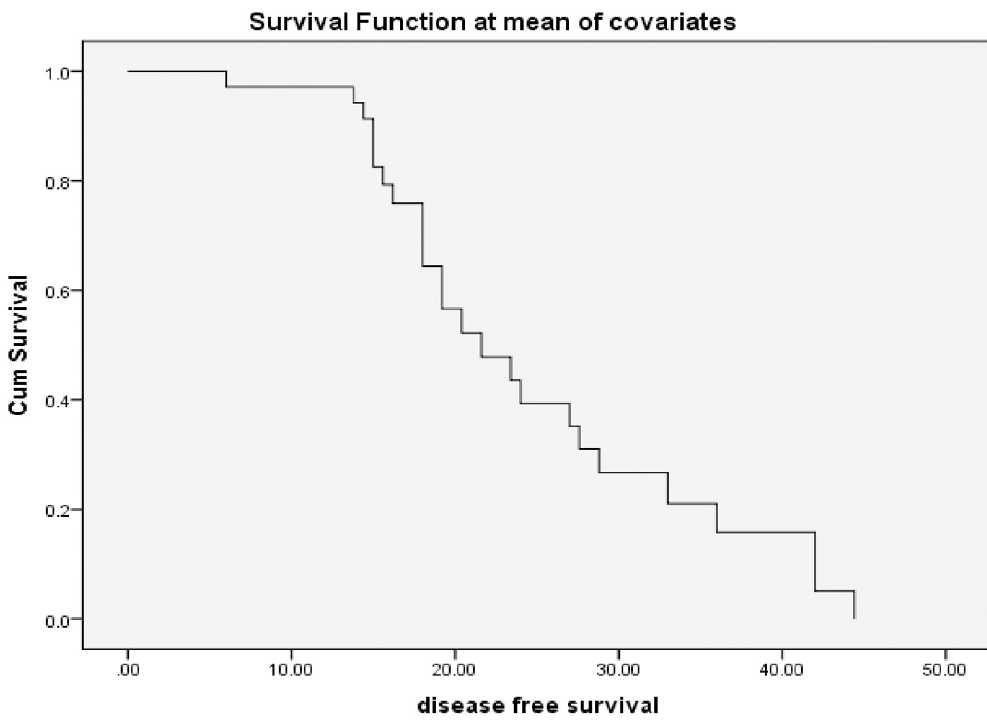
Fig 2. Disease-free survival (DFS) among 30 patients with triple-negative breast cancer (TNBC).